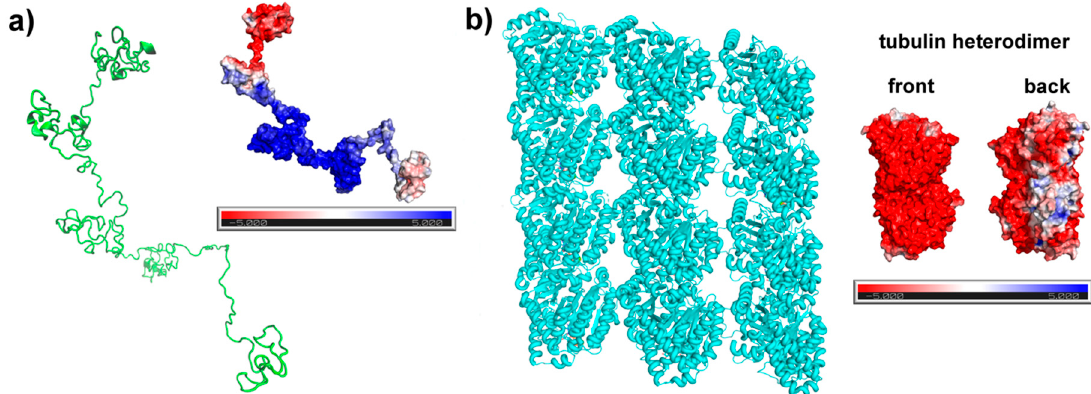
Figure 4. ( a ) Predicted structure of tau using I-TASSER and ( b ) 5JCO microtubule section from Protein Data Bank (PDB). Both structures are side by side to its electrostatic potential surface, which in red represents the negative potential values and in blue, the positive potential values. The electrostatic potential (k b T e c − 1 ) was calculated using APBS-PDB2PQR software. For the microtubule, the calculation was made using a tubulin heterodimer.